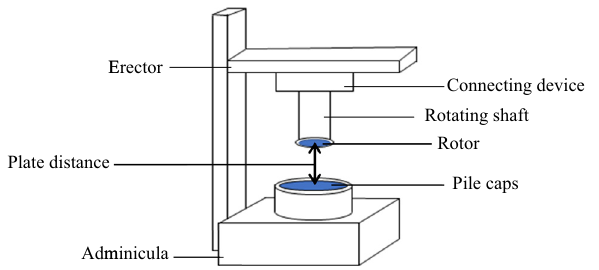
Figure 1: Schematic of rheometer device.